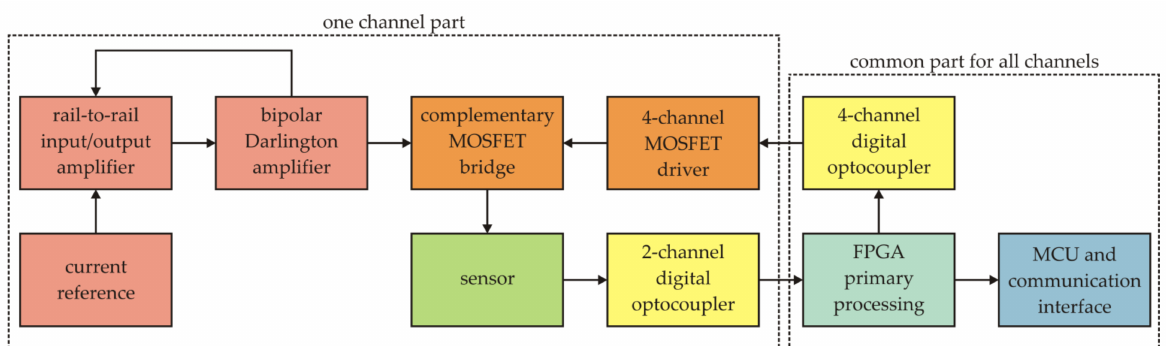
Figure 6. Block diagram of the measurement chain of one channel. The sample rate of the used VEMA magnetometer is 1000 Hz since the difference of the time intervals is evaluated twice within the 500 Hz excitation signal frequency (Figure 7). The frequency bandwidth is DC—250 Hz ( − 3 dB).